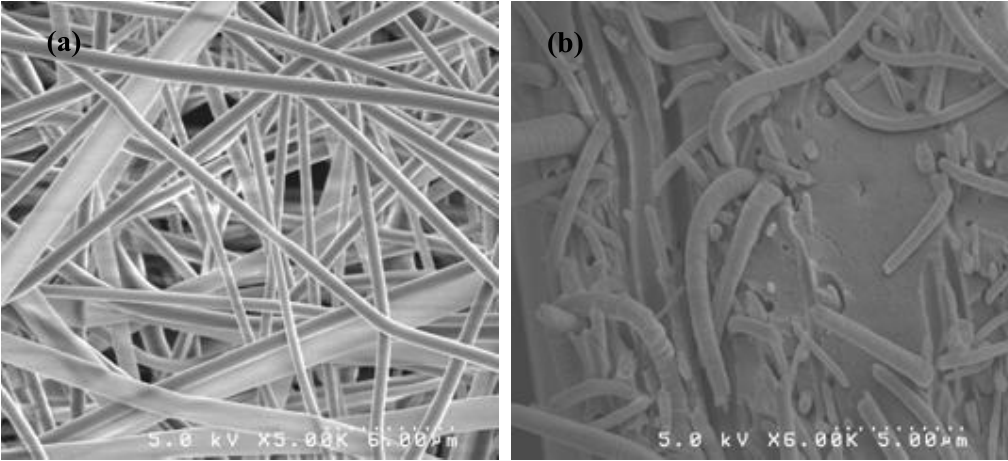
Figure 9. Scanning electron micrographs of electrospun nanofiber composite